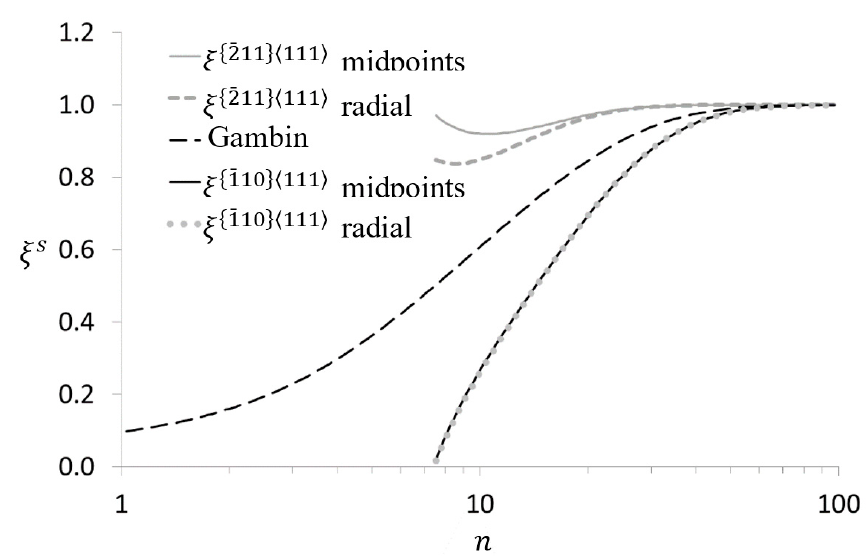
Figure 5. The fitted coefficients of the yield surface as functions of the exponent 𝑛 , for the case of bcc with (cid:4668) 1 (cid:4636) 10 (cid:4669)⟨ 111 ⟩ and (cid:4668) 2 (cid:4636) 11 (cid:4669)⟨ 111 ⟩ slip systems with 𝜏 (cid:3030)(cid:4668)(cid:2870)(cid:4636)(cid:2869)(cid:2869)(cid:4669)⟨(cid:2869)(cid:2869)(cid:2869)⟩ = 0.95𝜏 (cid:3030)(cid:4668)(cid:2869)(cid:4636)(cid:2869)(cid:2868)(cid:4669)⟨(cid:2869)(cid:2869)(cid:2869)⟩ , fitted to facet midpoints, by the regularization proposed by Gambin, and radially to the facets.